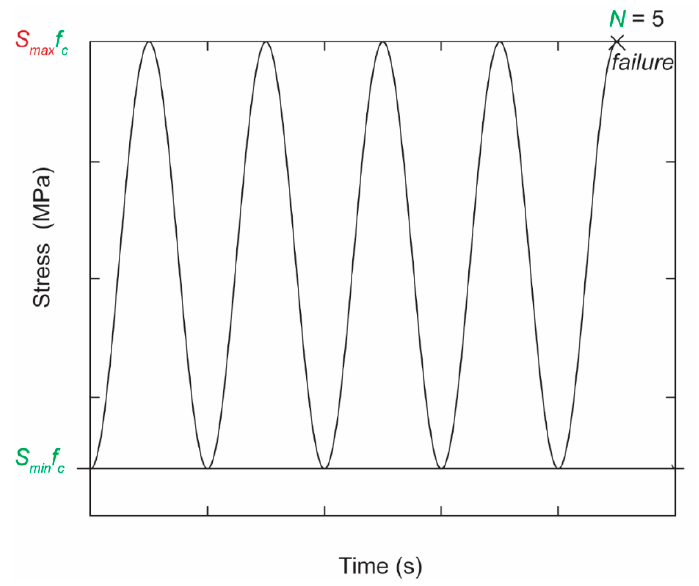
Figure 3. Input (green) and output variables (red), shown on an example of a loading scheme in an experiment.